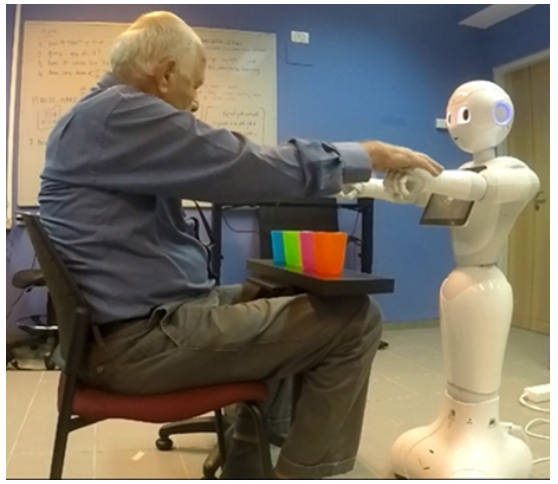
Figure 3: In order to indicate completion of the task the participant is petting the robot’s hand. Table 1: The custom-built questionnaire of Experiment 1.